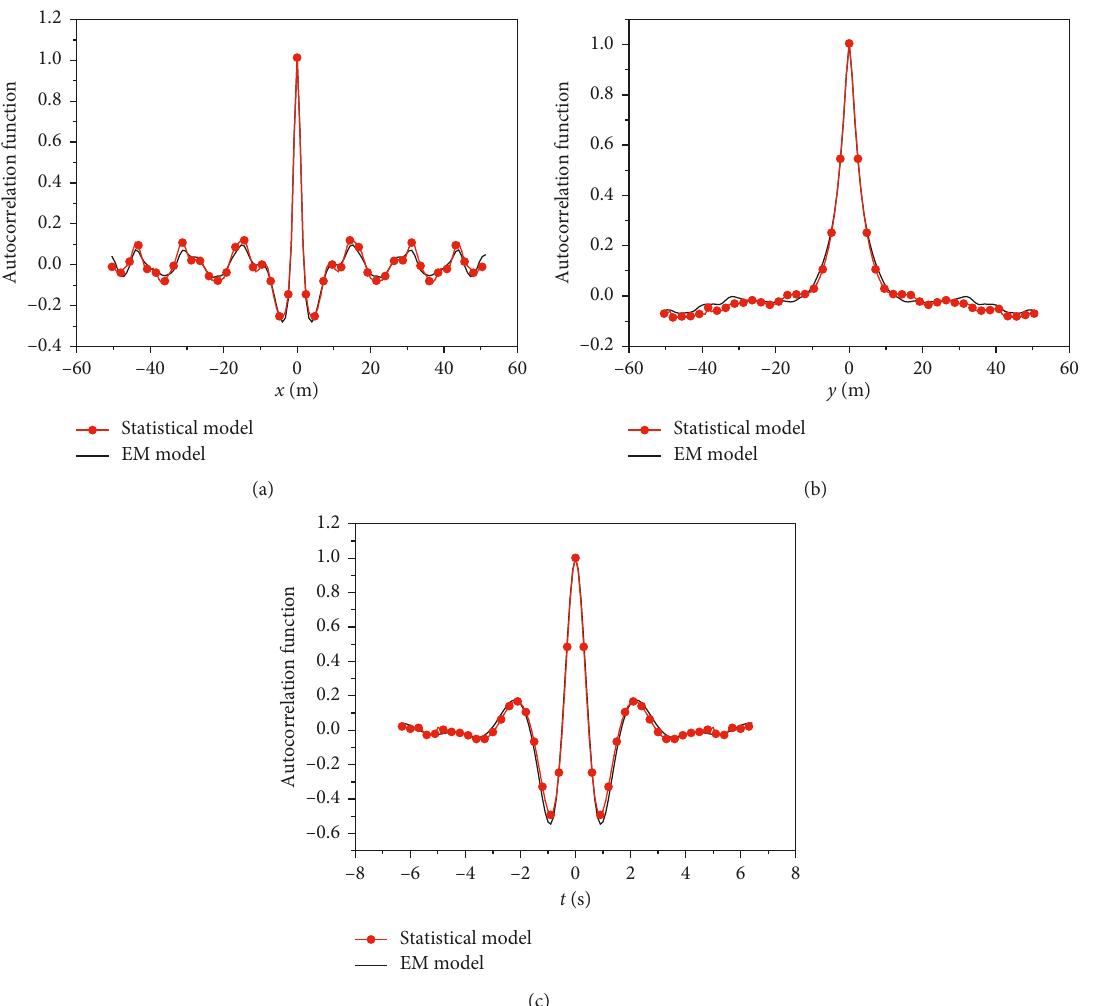
Figure 7: Comparison of 1D plots of the autocorrelation function of 3D sea clutter at x , y , and t direction between statistical and EM